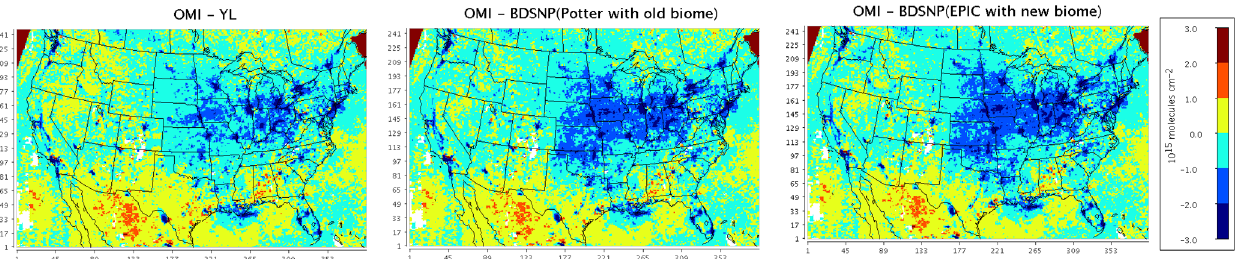
Figure B3. Difference of OMI NO 2 column with NO 2 column simulated from the three in-line CMAQ cases: YL, BDSNP ( et al. (2010) with old biome), BDSNP (EPIC with new Biome) (left to right) over OMI overpass time averaged for July 2011 over CONUS. Note: in contour plots, white refers to gaps/no-fill values in OMI product and dark red at upper corners are due to gaps in CMAQ NO 2 column after temporal averaging at OMI overpass